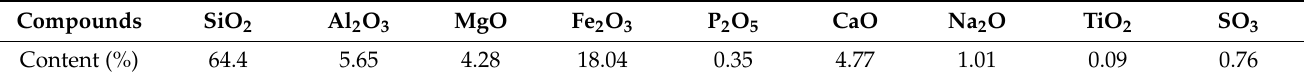
Figure 2. Particle size distribution of tailings. Table 1. Chemical compositions of